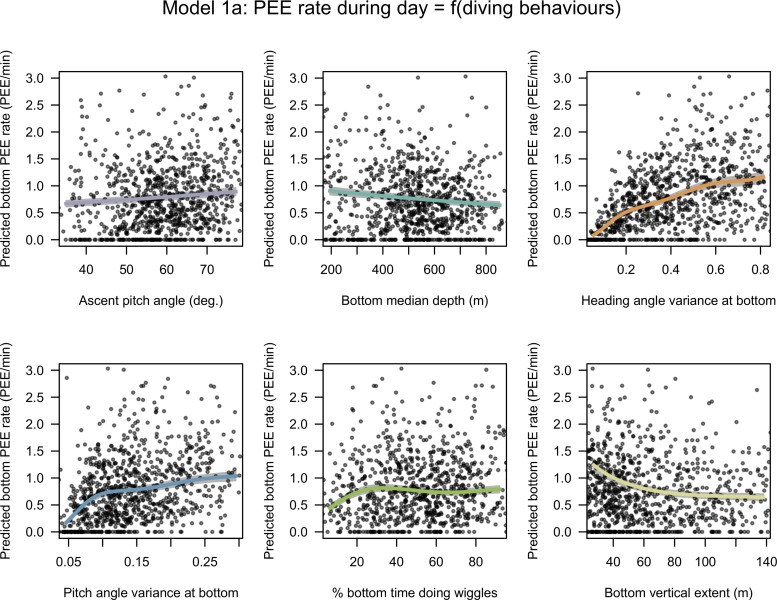
Estimated effects of covariates selected in model 1a.Expected response predicted with a covariate varying from the 5% to the 95% quantile of its observed values with other covariates at their mean. The x axes have been scaled to range from -2 to 2 normalized so that regression slopes are comparable but are annotated with raw units so that units are comprehensible. The grey shades around the regression lines indicate the standard error of the mean prediction estimates.